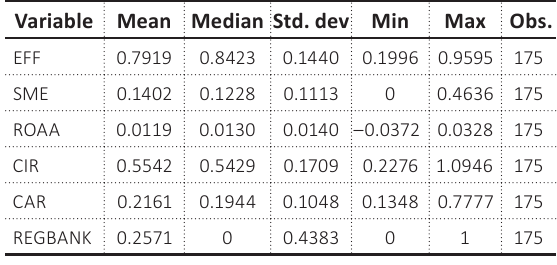
Table 6. Pairwise correlation of EFF and